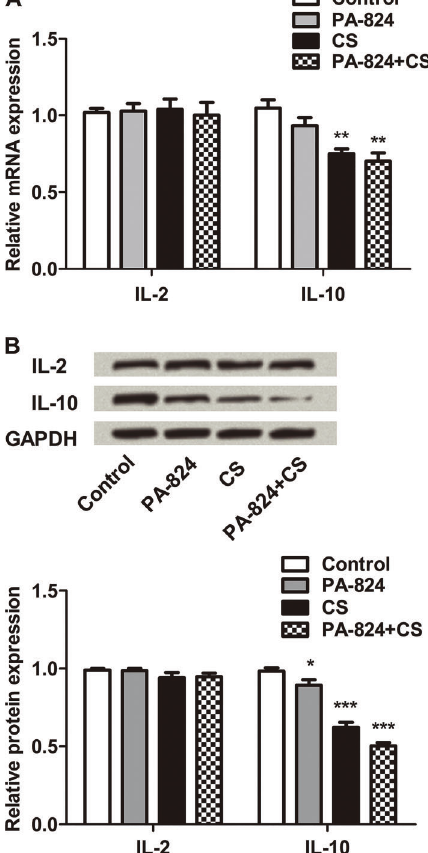
Figure 5. IL-2 and IL-10 expression in the lung during infection after administration of PA-824, CS or the combination of both. The mice lungs after treatment were stripped out and prepared for analysis. A , mRNA expression level of IL-2 and IL-10 in the mice lung by real-time PCR. B , Protein immunoblots and quanti fi cation of IL-2 and IL-10 in M.tb infected mice lungs after treatment. GAPDH acted as an internal control. CS: Cordyceps sinensis (Berk.) Sacc.; M.tb : Mycobacterium tuberculosis ; IL-2: interleukin-2; IL-10: interleukin-10. *P o 0.05, **P o 0.01, ***P o 0.001, compared to control